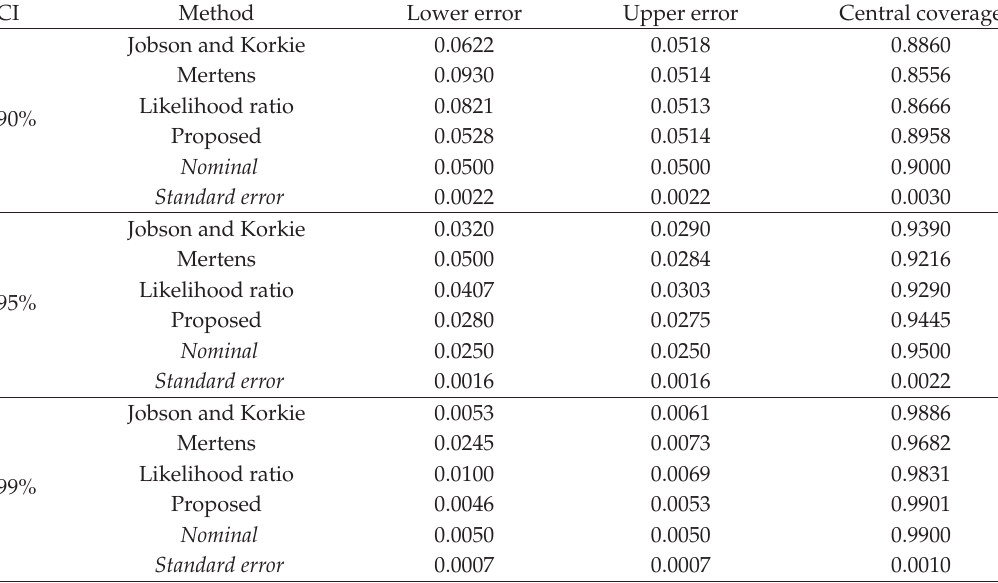
Table 6: Results for simulation study for market for n (cid:6)